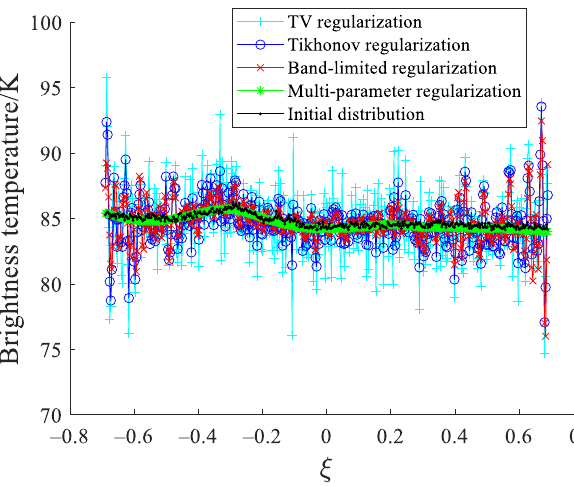
Figure 3. Reconstructed results of the ocean in the alias-free field of view.